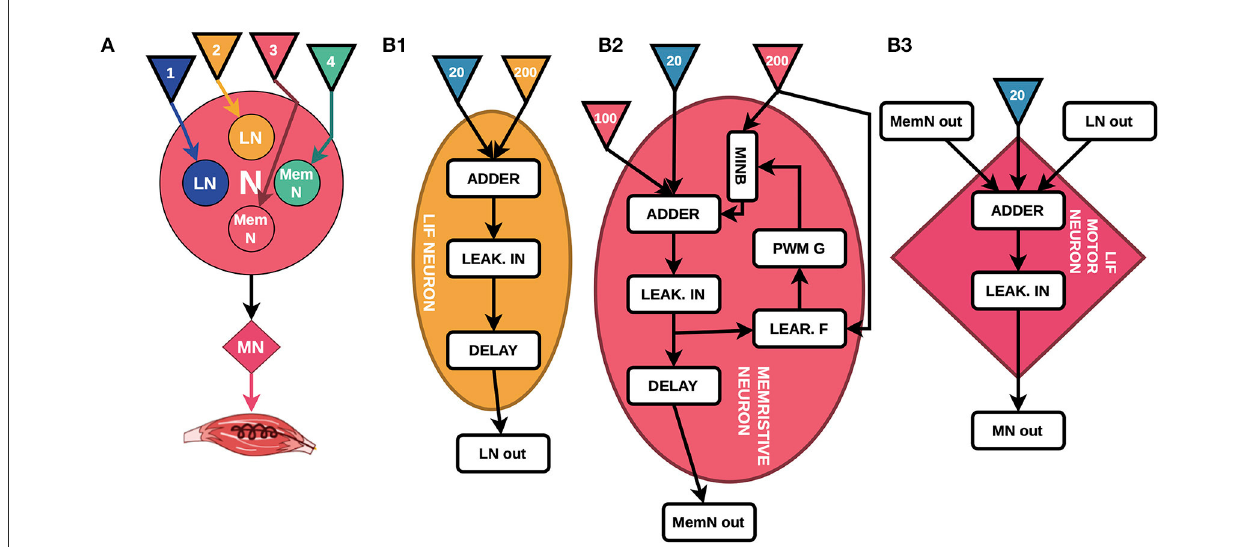
FIGURE1 (A) High-level design diagram, where LNs are LIF neurons, MemNs are memristive LIF neurons, MN is a motor neuron, and colored triangles are sensory fibers coming from insole (numbers correspond to periods of 200 Hz pulses in Figures 2A2–A5). (B) The detailed block diagrams of all types of neurons. (B1) LIF neuron is the basis of MemNs and consists of Adder, Leakage Integrator (LEAK. IN), Delay, and inputs of 200 Hz (yellow triangle) and 20 Hz pulses (blue triangle). (B2) The principal schematic of MemN consisting of Learning Feedback (LEAR. F), Pulse-width modulation Generator (PWM G), Memristive device Integration Block (MINB), and additional 100 Hz pulses input (pink triangle). (B3) Motor neuron consisting of Adder that sums up signals from four neurons and 20 Hz pulses, LEAK. IN and Delay.